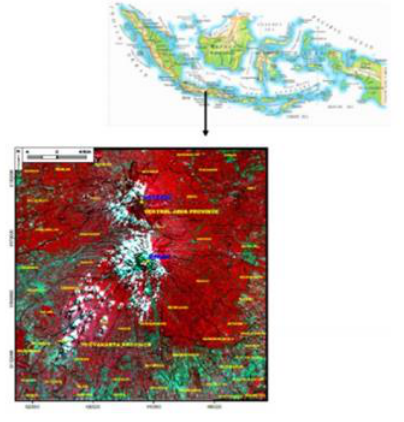
Figure 1. Merapi Volcano Spatial